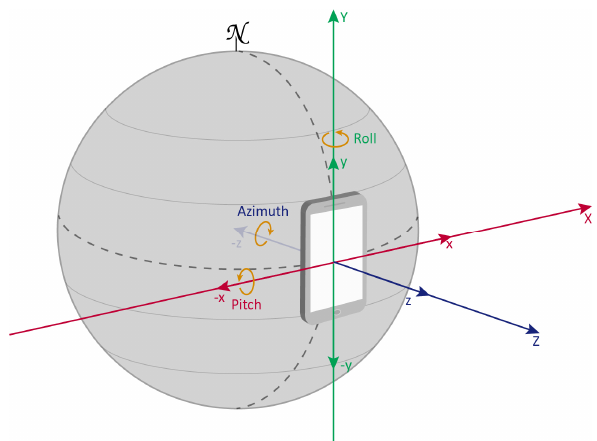
Figure 1. Smartphone sensor coordinate system in relation to a world coordinate system.